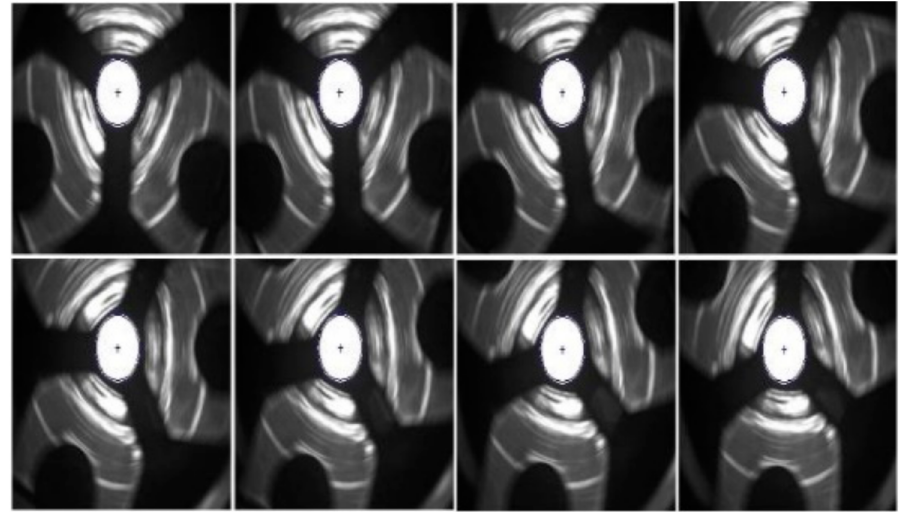
Figure 33. A sequence of master cylinder images acquired at a spindle speed of 25 rpm [32]. In further data processing, the software controlling the measurement system automat- ically analysed the collected shots and performed the next steps of the research algorithm to detect edges based on the so-called Canny operator (Figure